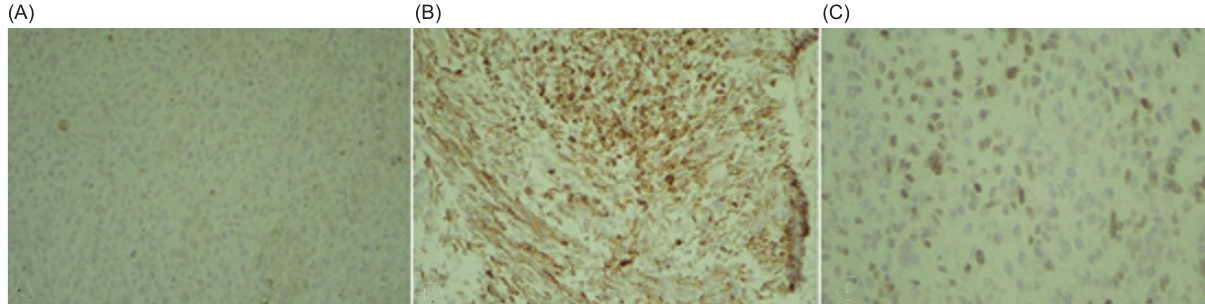
Figure 3: Immunohistochemistry positive reaction for (A) Creatine kinase. (B) Desmin. (C) Myogenin.